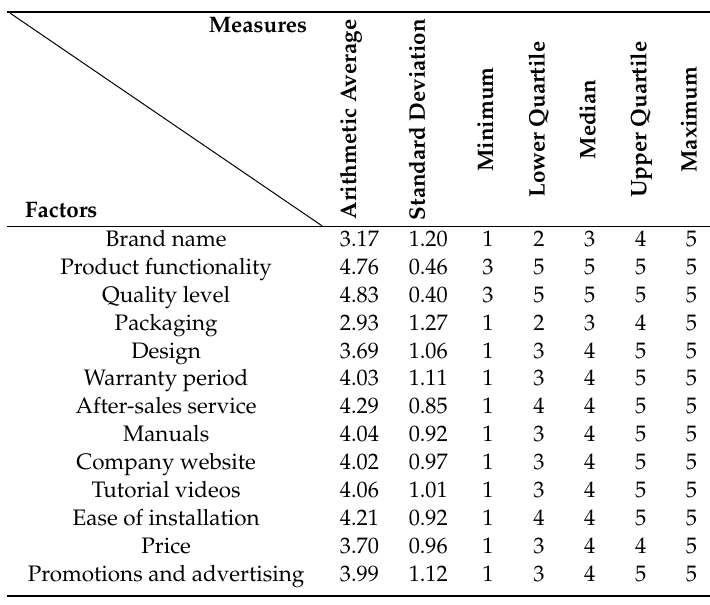
Table 1. Assessment of the factors influencing international customer satisfaction in the airsoft industry. Source: own elaboration (n =